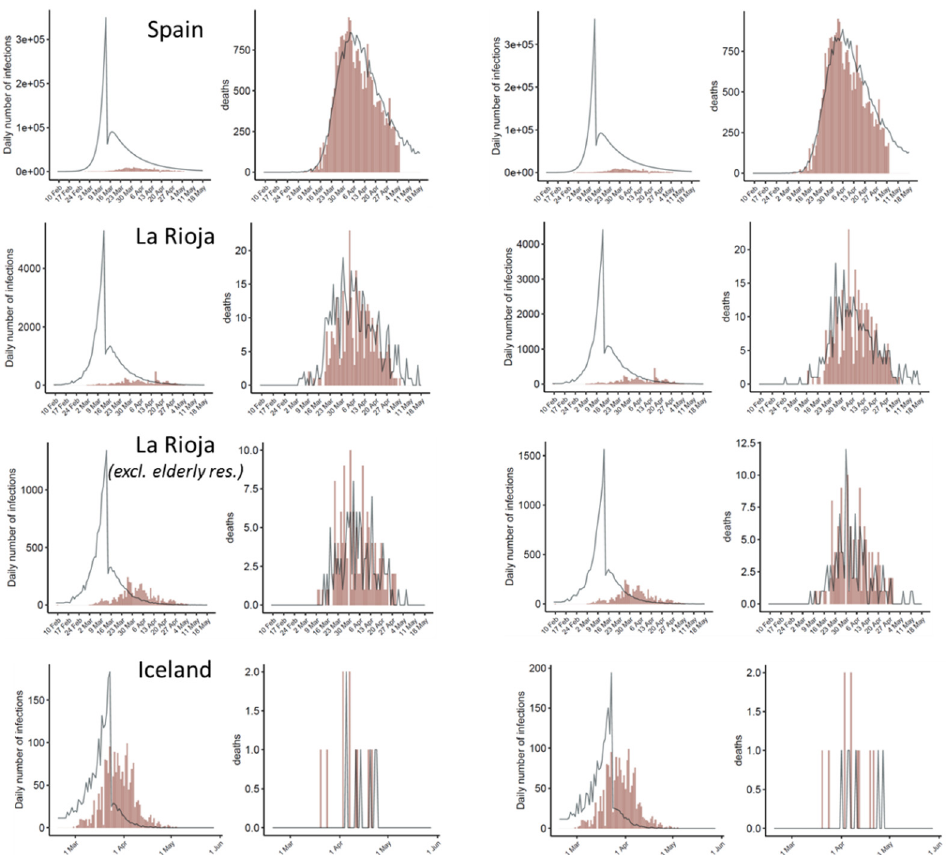
Figure 5. Instances of discrete distributions of the estimated number of daily infections and deaths randomly sampled according to the serial interval and infection-to-death probability distributions, based on randomly selected sets of reproduction numbers and initial infections among the ones obtained by the fitted model (black lines), as compared to the reported data (brown bars). Each row represents a country, with two instances of discrete distributions. When the number of daily infections and deaths is large (e.g., Spain), the predicted discrete distributions are closer to the continuous ones (Figure 3), but when these numbers are smaller (e.g., La Rioja and Iceland), the discrete distributions resemble better the rough distribution of reported data over time. In the La Rioja second panel, observed deaths do not include those from elderly retirement homes, but daily reported cases are the total ones, since daily cases excluding elderly retirement homes was not available for this